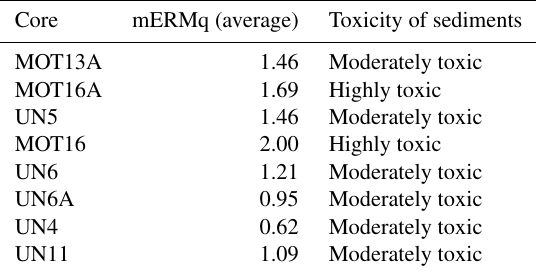
Table 8. The mERMq values calculated for the surface sediments (0–9cm) of the collected cores of the western Saronikos Gulf by dividing the average concentration (mgkg − 1 ) of each metal (Cr, MOT13A, MOT16 and UN4, the concentrations of total sediment ( < 1mm) were